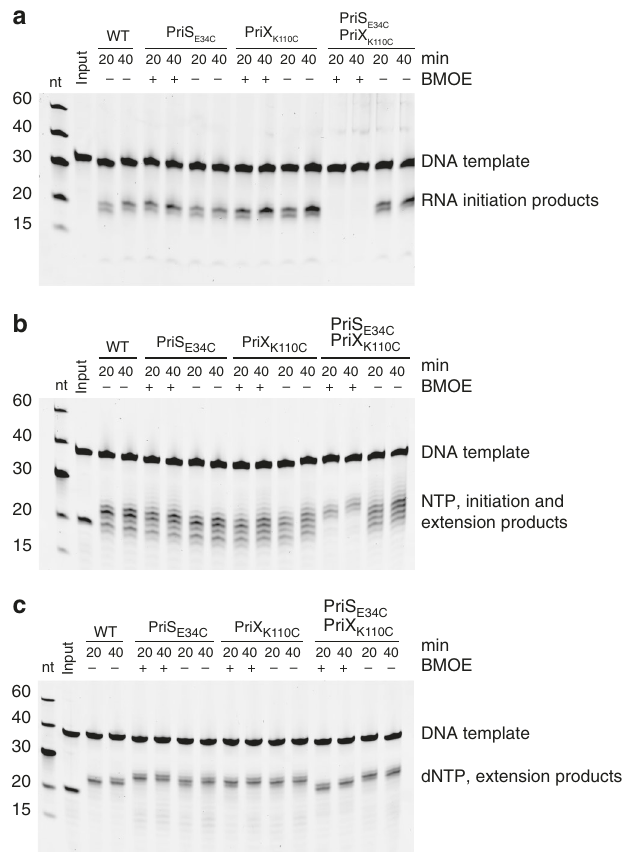
Fig. 8 Primer synthesis assay for the cross-linked Chimera. For all experiments, wild-type Chimera, PriS E34C and PriX K110C single mutants and PriS E34C, PriX K110C double mutants were analyzed. Cross-linking reactions were analyzed at 20 ′ and 40 ′ time points, with and without BMOE. The reaction products were separated by denaturing PAGE, stained with SYBR Gold and detected by phosphorimaging. a Primer